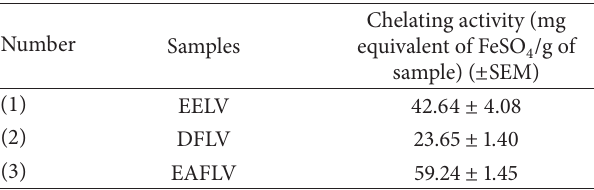
Table 3: Chelating activity of iron of the ethanolic extract and fractions of L. venustum.